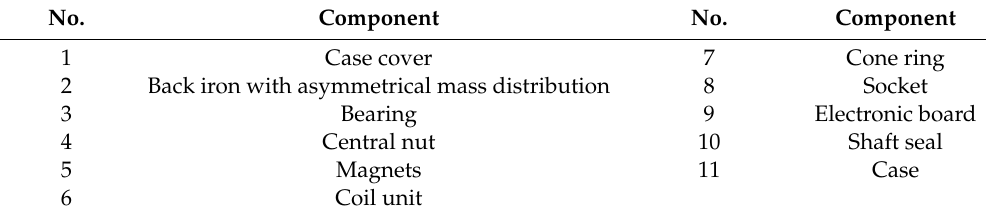
Figure 3. Sectional view of the energy harvester. Table 3. Energy Harvester components.